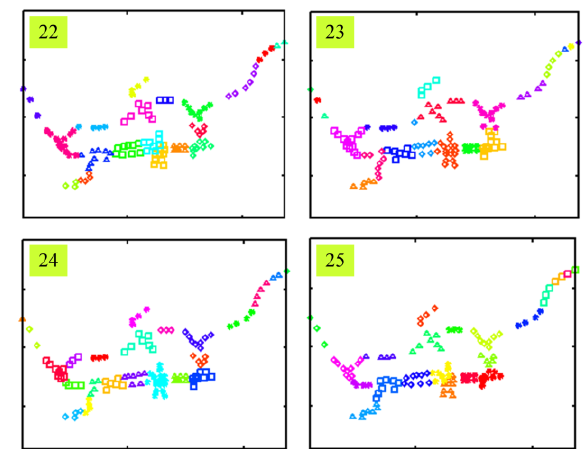
Figure 12. Clustering results for K inside interval [22, 25]